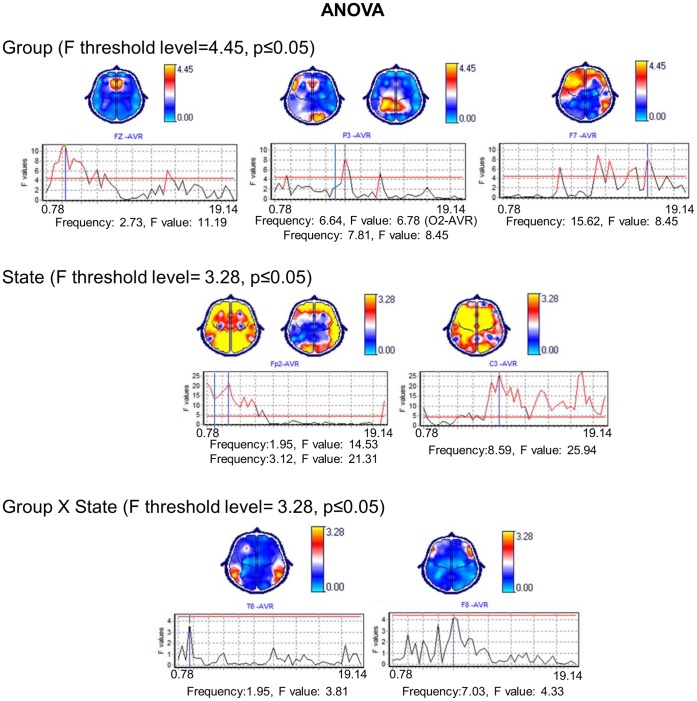
ANOVA global results.Representative frequencies are shown accompanied by a graph with all of the narrow-band frequencies included in the X-axis and the F values in the Y-axis. The represented frequencies are marked by vertical blue lines that cross the frequency in question. The threshold levels (p≤0.05) are shown by horizontal red lines. Topographic maps show in yellow the cerebral regions in which the significant differences were identified.